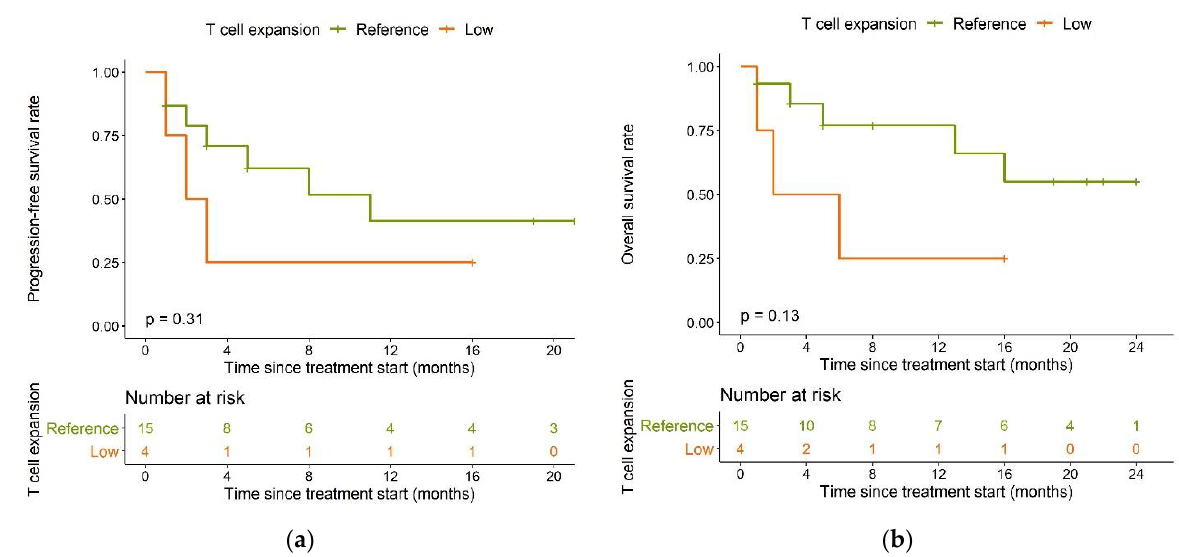
Figure 6. Kaplan – Meier plots for ( a ) progression-free survival and ( b ) overall survival in the reference T cell expansion population (green) and the low expansion subpopulation (orange); log-rank tests.